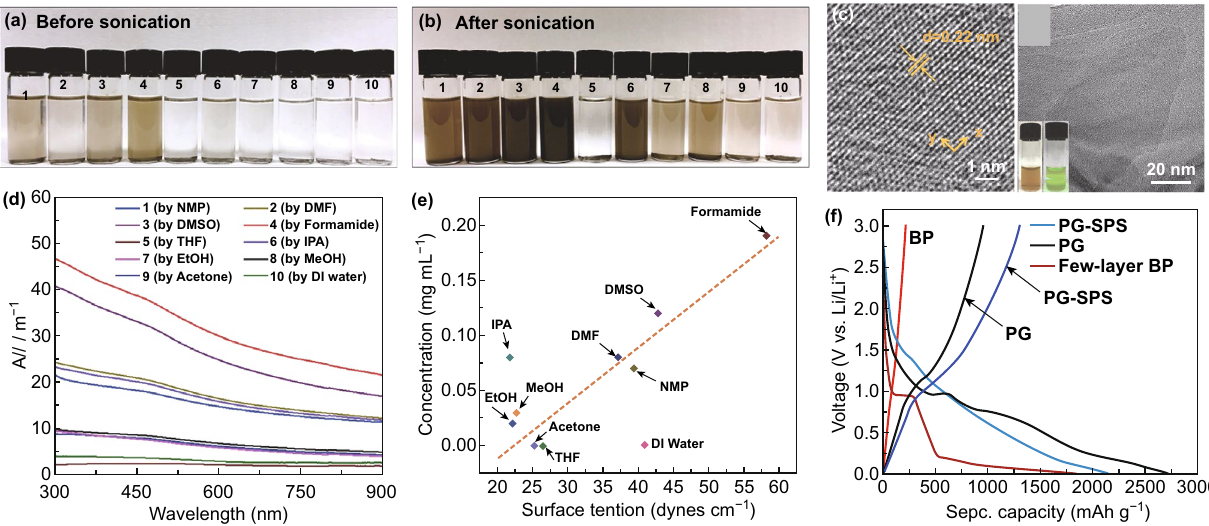
Fig. 7 a Liquid exfoliation of black phosphorus in a series of organic solvents before sonication. b Solution containing 2D black phosphorus stored 12 h after sonication. c HRTEM and TEM images of black phosphorus collected after centrifugation at 2000 and 400 rpm lying on the left and right side, respectively. Insets are the pics (brown) and Tyndall effect (green) of the BP at 4000 rpm dispersions in formamide. d Optical absorption spectrum of minor dispersions in ethanol. e Surface tension of solution containing black phosphorus with different concentration in a different organic solvent. f First cycle of galvanic charge/discharge performance of thin-layer BP, 2D BP/graphene and 2D BP/graphene with spark pulsed sintering at a current density of 100 mA g −1 . Adapted with permission [187]. Copyright 2016 John Wiley and Sons. (Color figure